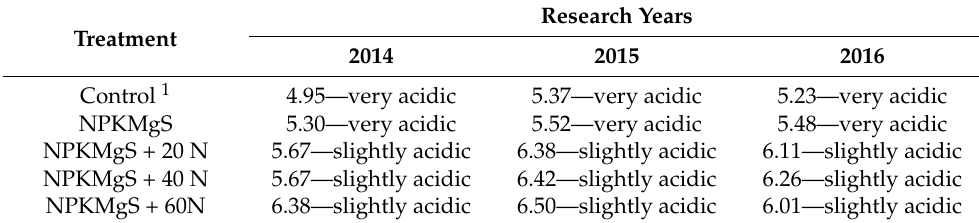
Table 1. Soil pH in the years of research.